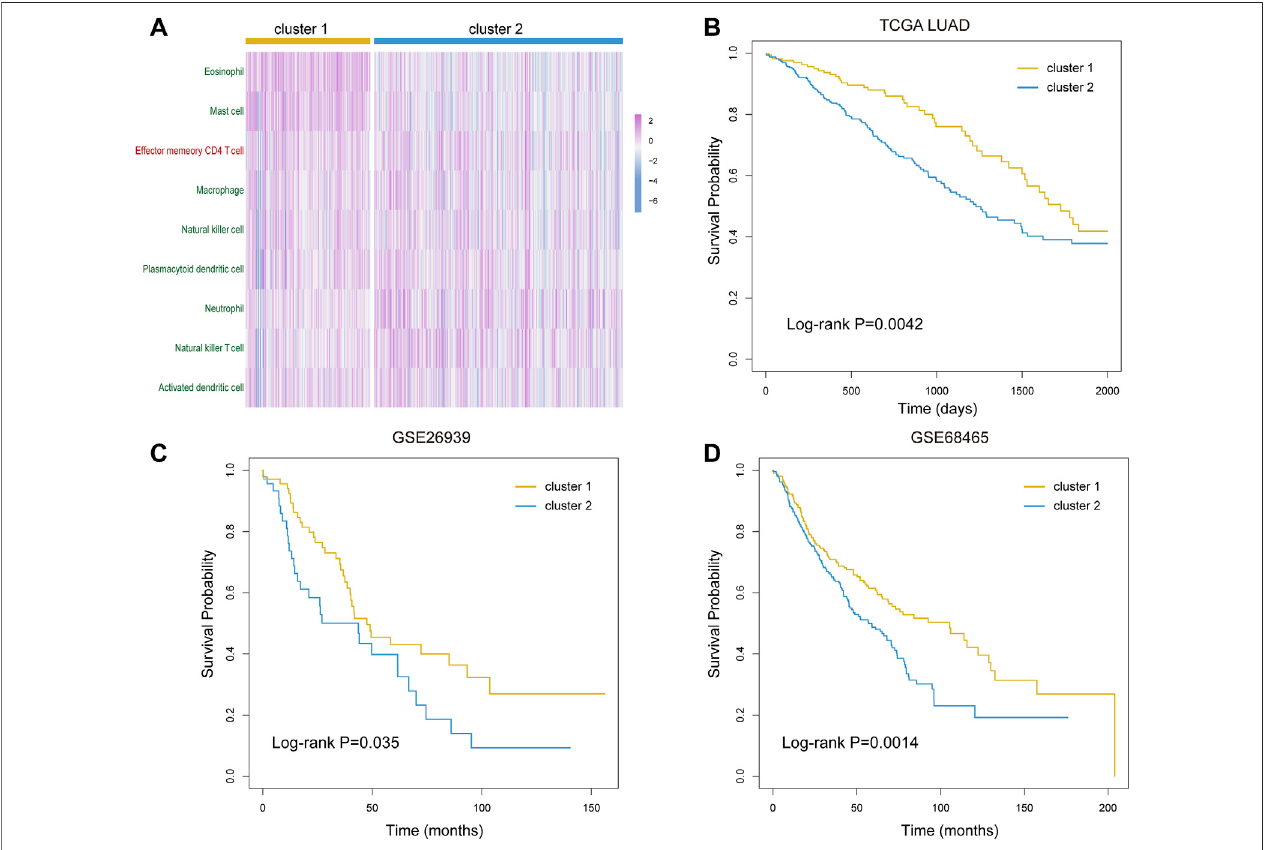
FIGURE6| Prognosticevaluationoftheselected nineimmunecells. (A) In fi ltration pro fi le oftheselectednine immune cellsin cluster1and cluster2groups. (B – D) Kaplan – Meier curves of overall survival in cluster 1 and cluster 2 groups of LUAD patients from TCGA (B) , GSE26939 dataset (C) , and GSE68465 dataset (D) .